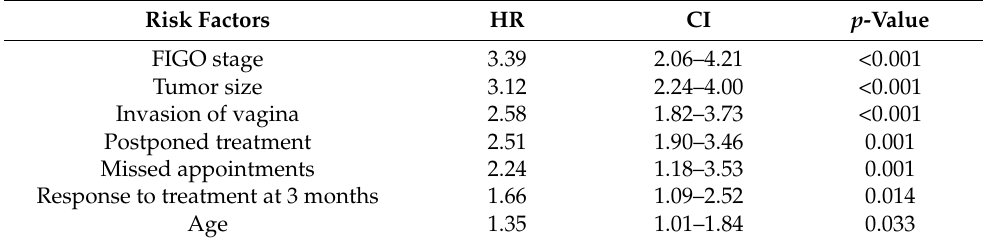
Table 4. Risk factors for disease progression after finishing the radiation therapy regimen.